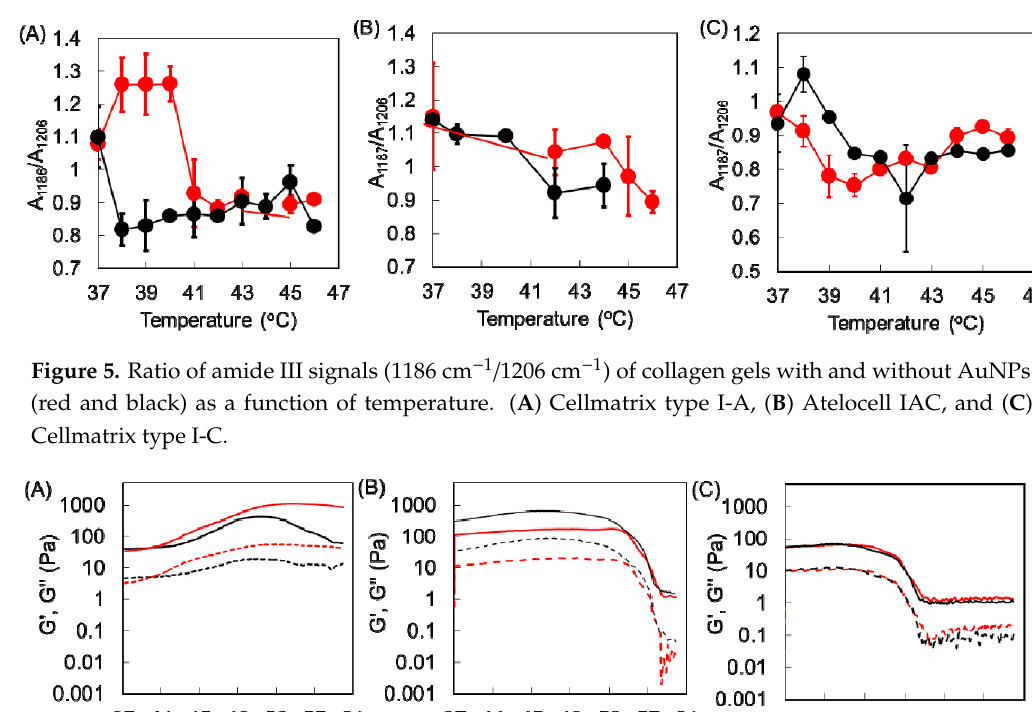
Figure 4. FTIR spectra of the collagen solution, the concentration medium, and the regenerative solution.